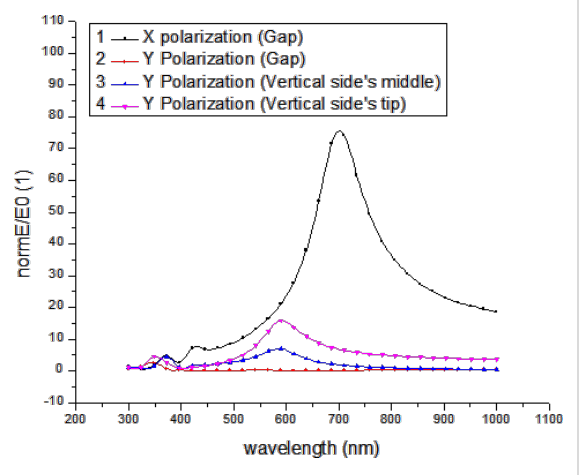
Figure 11: Calculated field-enhancement factor (normalized to the amplitude E 0 of the incident light) for bowtie nanoantennas at different positions and for different polarization of the incident light.